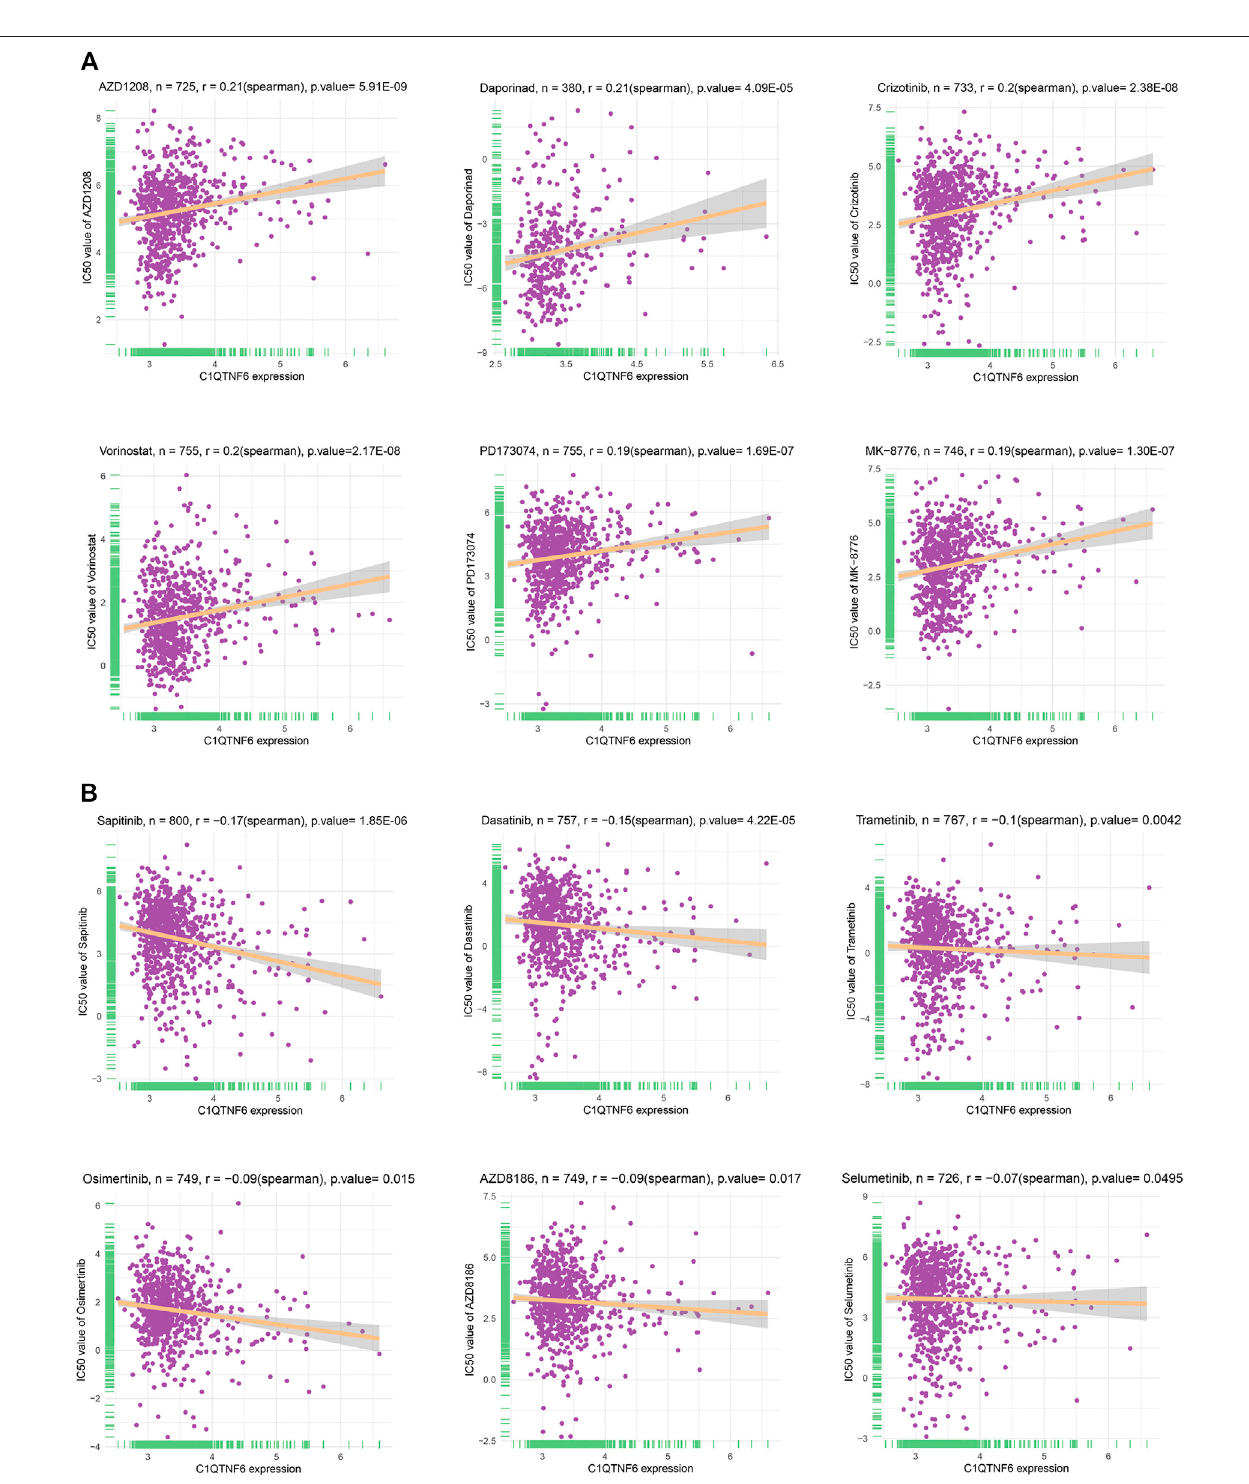
FIGURE 8 | Drug sensitivity analysis in the form of correlation chart calculated by online tool GDSC2. (A) The top 6 positively correlated. (B) The only 6 negatively correlated.